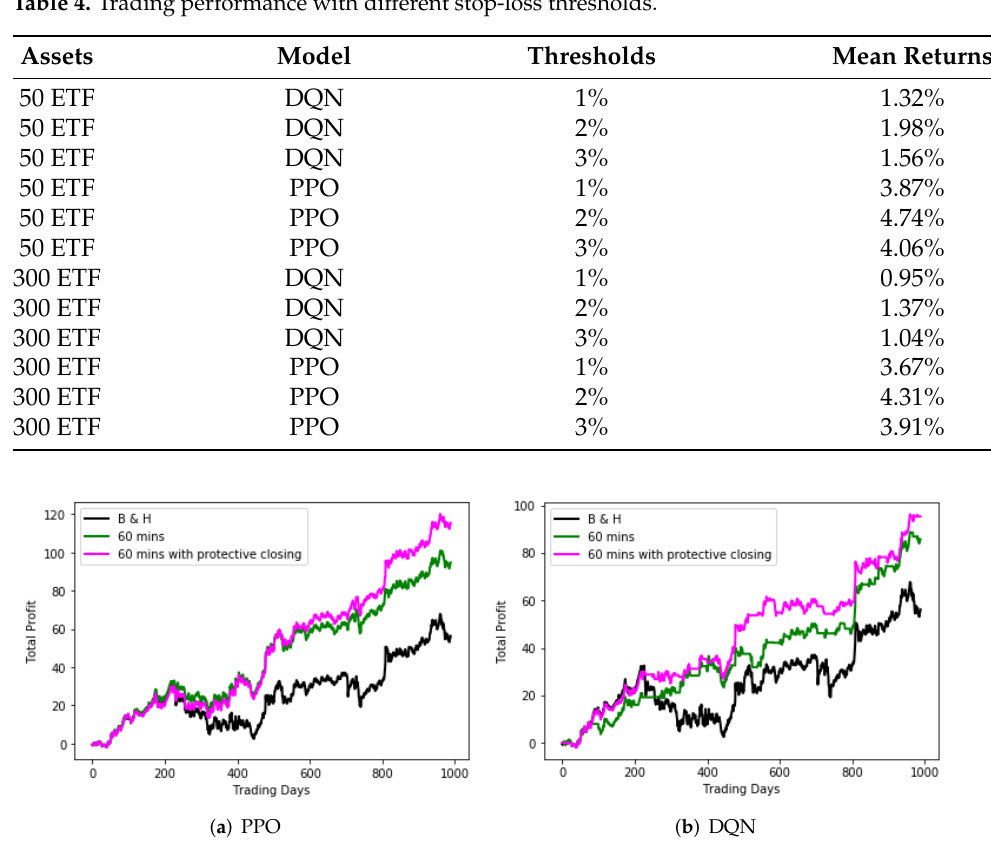
Table 4. Trading performance with different stop-loss thresholds.